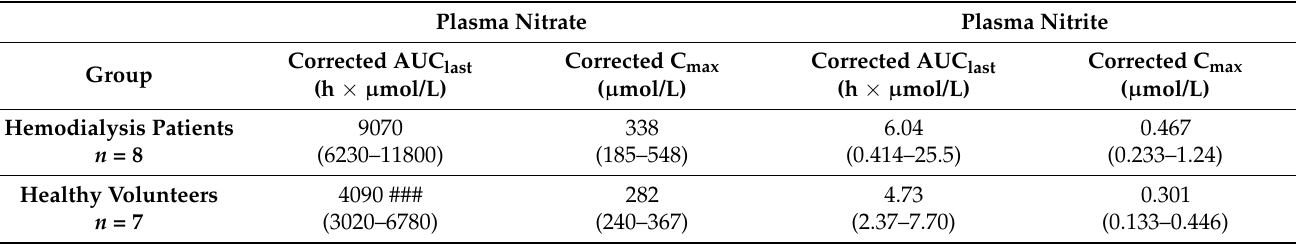
Table 6. Kinetic analysis of plasma nitrate and nitrite after single ingestion of nitrate-enriched (Active) and nitrate-depleted (Placebo) beetroot juice (BJ) in hemodialysis patients and in healthy